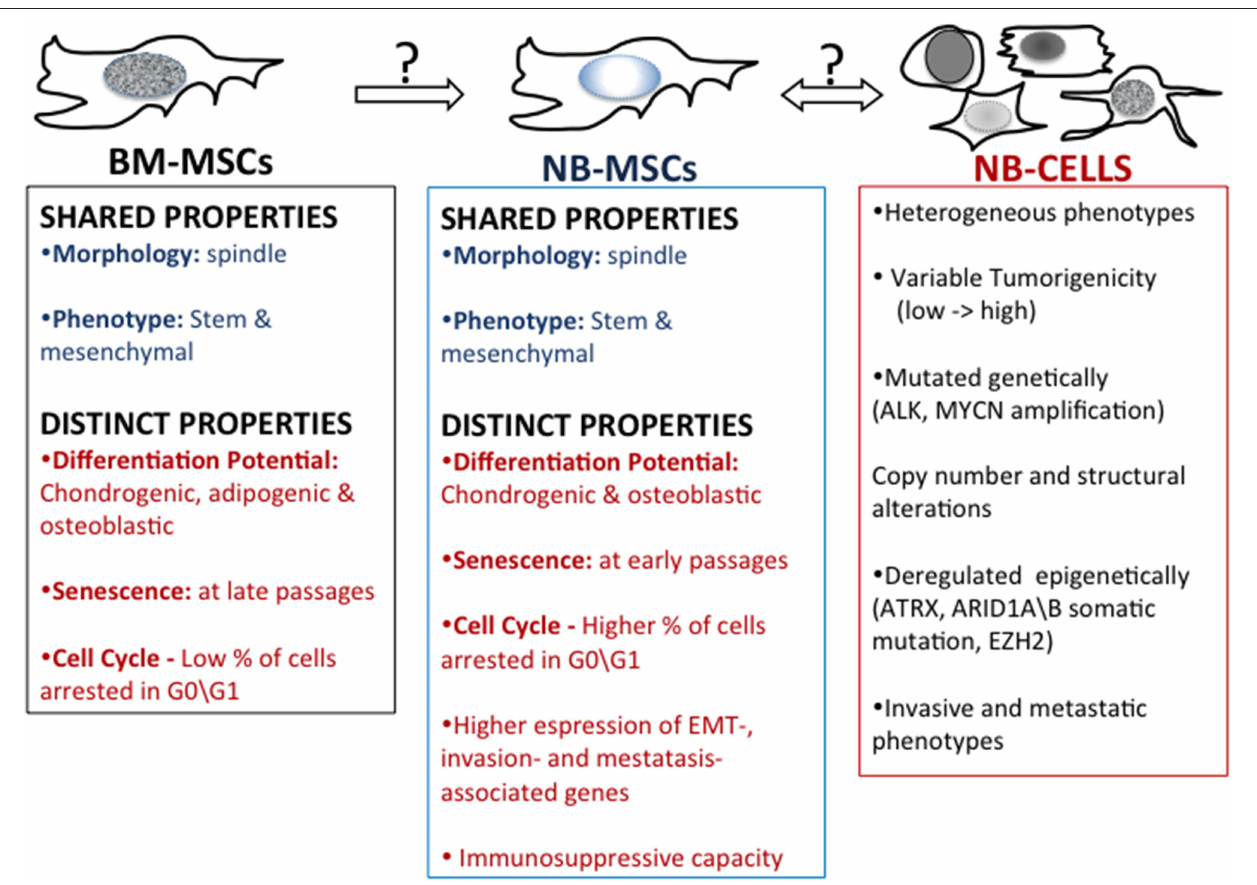
FIGURE 2 | Mesenchymal stem cells in neuroblastoma. A comparison of properties of bone marrow-derived mesenchymal stem cells (BM-MSC) and mesenchymal stem cells harvested from patient’s NB tumors (NB-MSC) and properties of NB tumor cells.